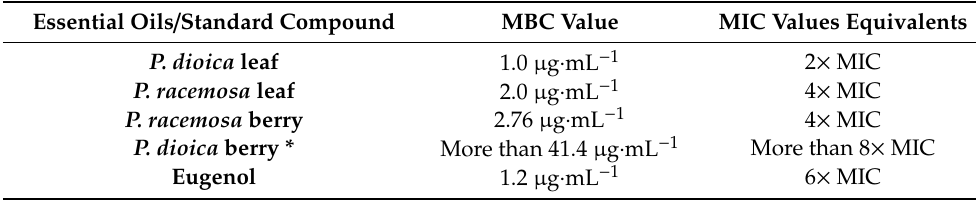
Table 2. The determined MBC values of Pimenta spp. leaf and berry essential oils tested against A. baumanii isolate-8 (AB-8) and their MIC values